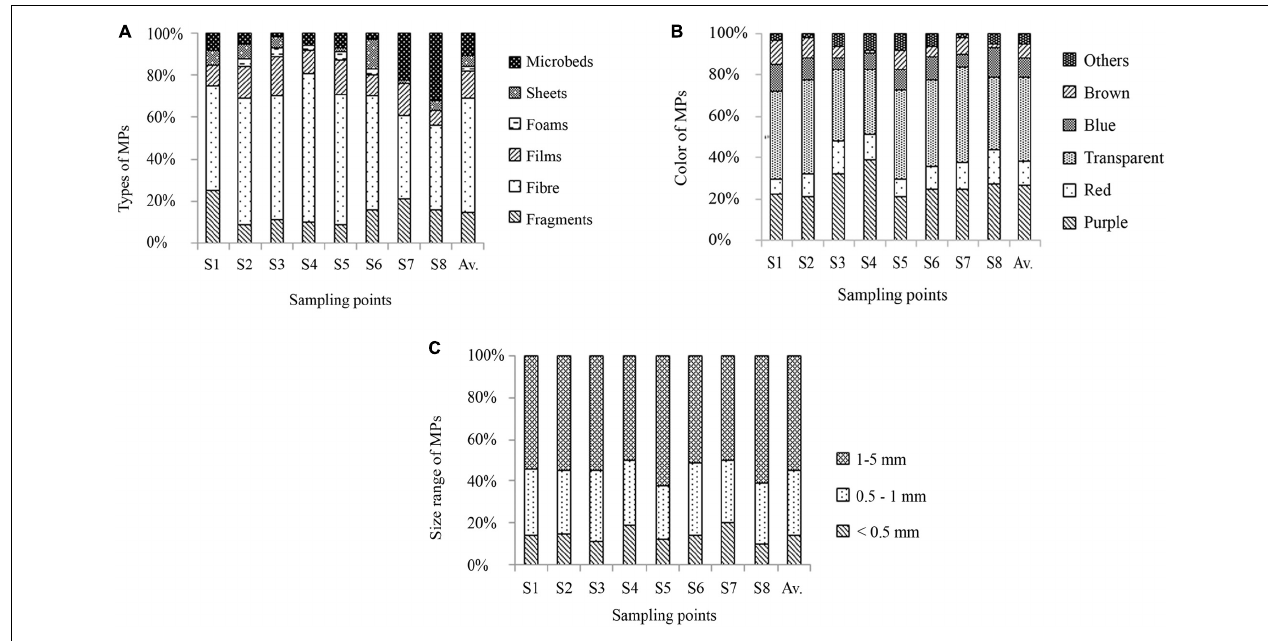
FIGURE 4 | Characteristics of microplastic, (A) types; (B) color; and (C) size.